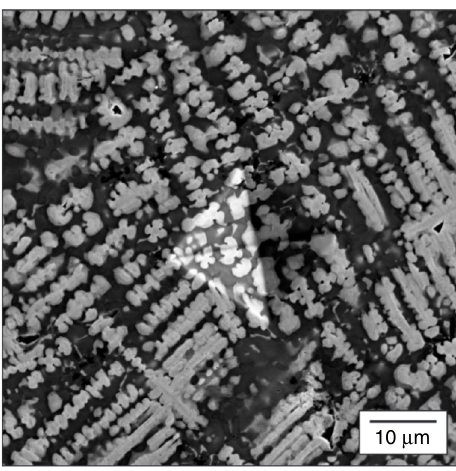
Fig. 7 Micrograph of a soft alloy. A scanning electron microscopic micrograph in a region near a microhardness indent in Ti 39 W 04 Nb 31 Ta 04 Co 22 in a sample that was synthesized by arc-melting. The fi gure shows a dendritic microstructure similar to that of traditionally cast